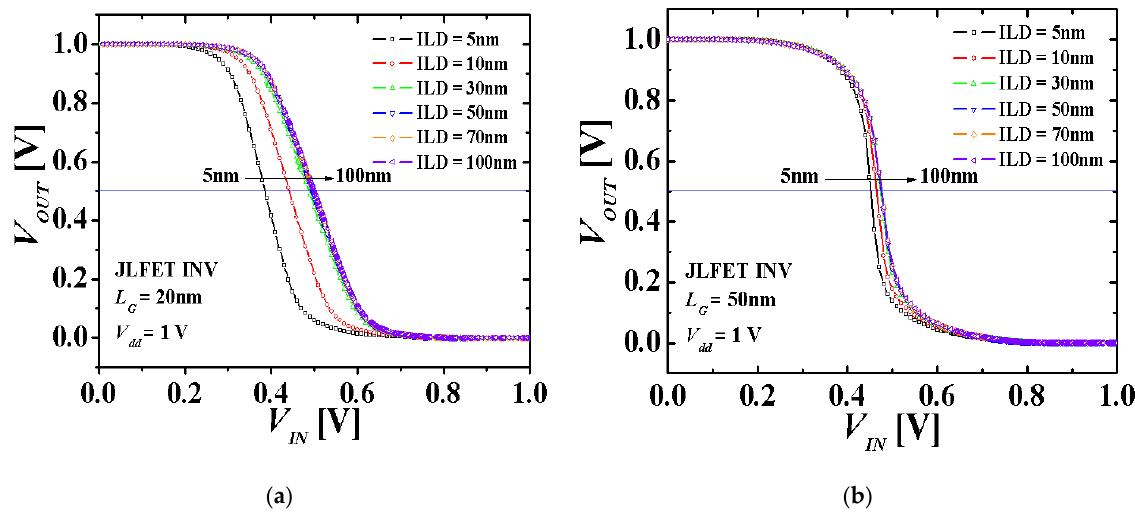
Figure 6. Voltage transfer characteristics of M3INV-JL cell with ( a ) L G = 20 nm and ( b ) L G = 50 nm. V dd (=1 V) is DC-biased.